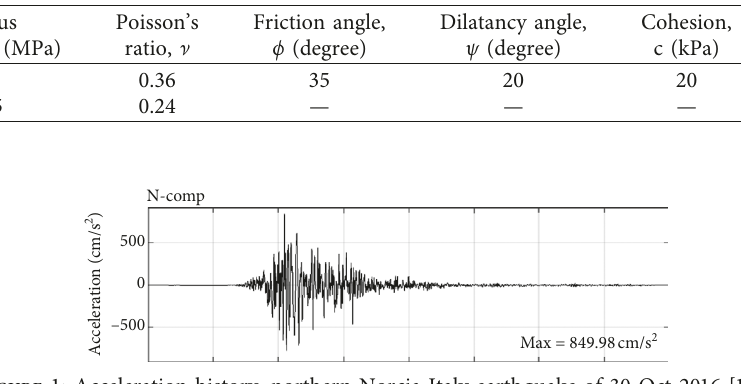
Table 1: Soil and concrete mechanical properties [11, 12].